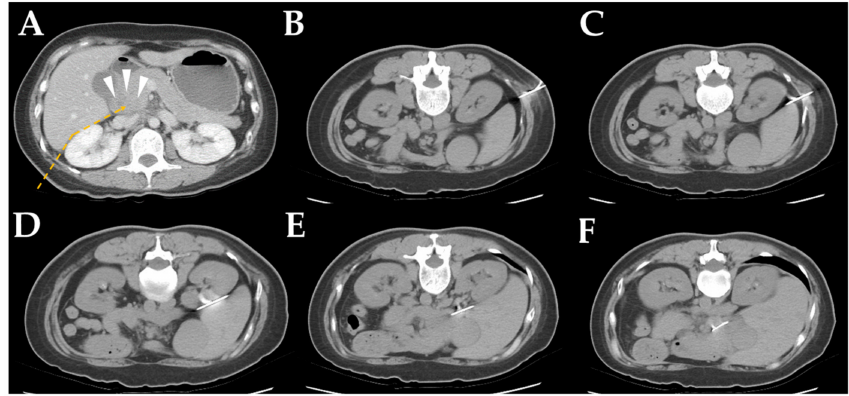
Figure 2. Computed tomography (CT)-guided, core needle biopsy images via detour route 6 in